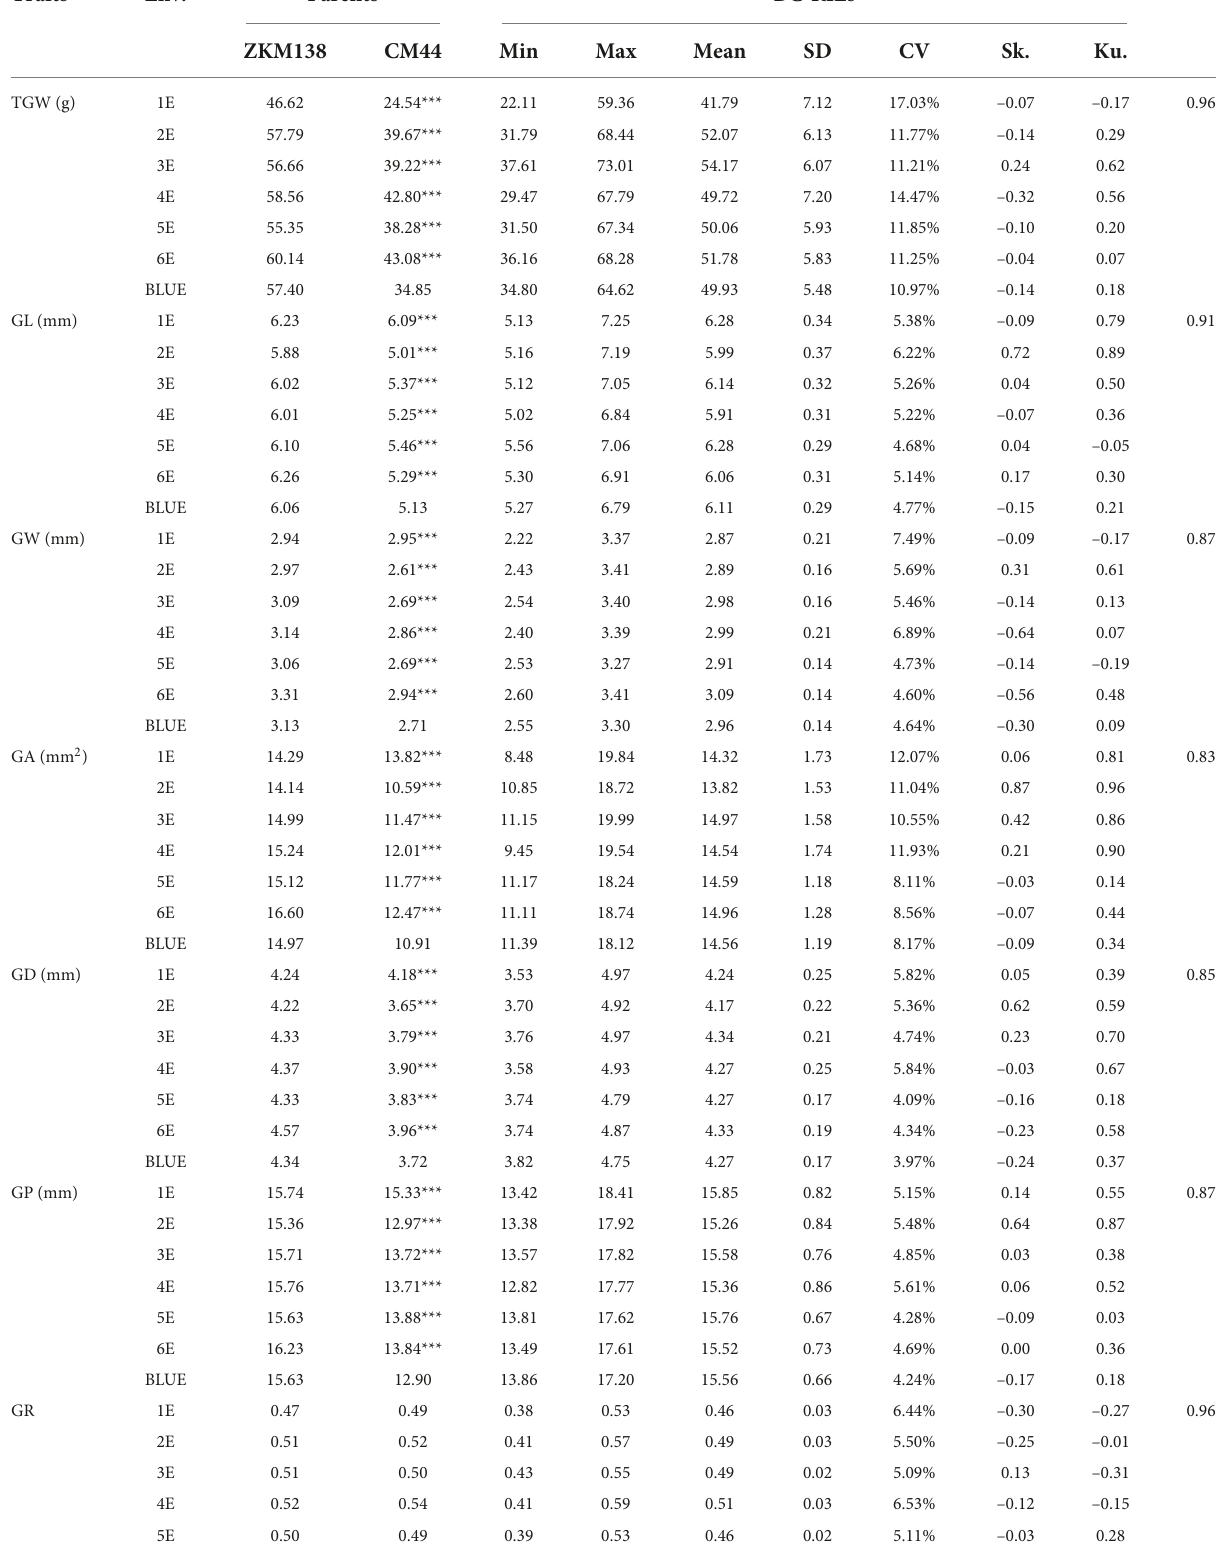
TABLE 1 Phenotypic variation and heritability ( H 2 ) of thousand grain weight (TGW) and grain-related traits (GRTs), for the parents and the BC-RILs in different environments. Traits